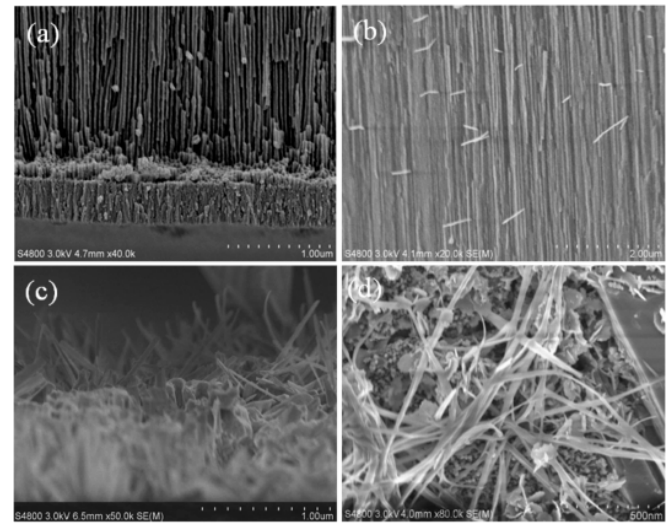
Figure 5. ( a ) FE-SEM image of the sectional view for sputtering a layer of platinum on the AAO template surface. ( b ) FE-SEM image of the electrodepositing the Sn material in the AAO template. ( c ) FE-SEM image of the cross-section of the SnO nanowires. ( d ) FE-SEM image of the top view of the SnO nanowires.